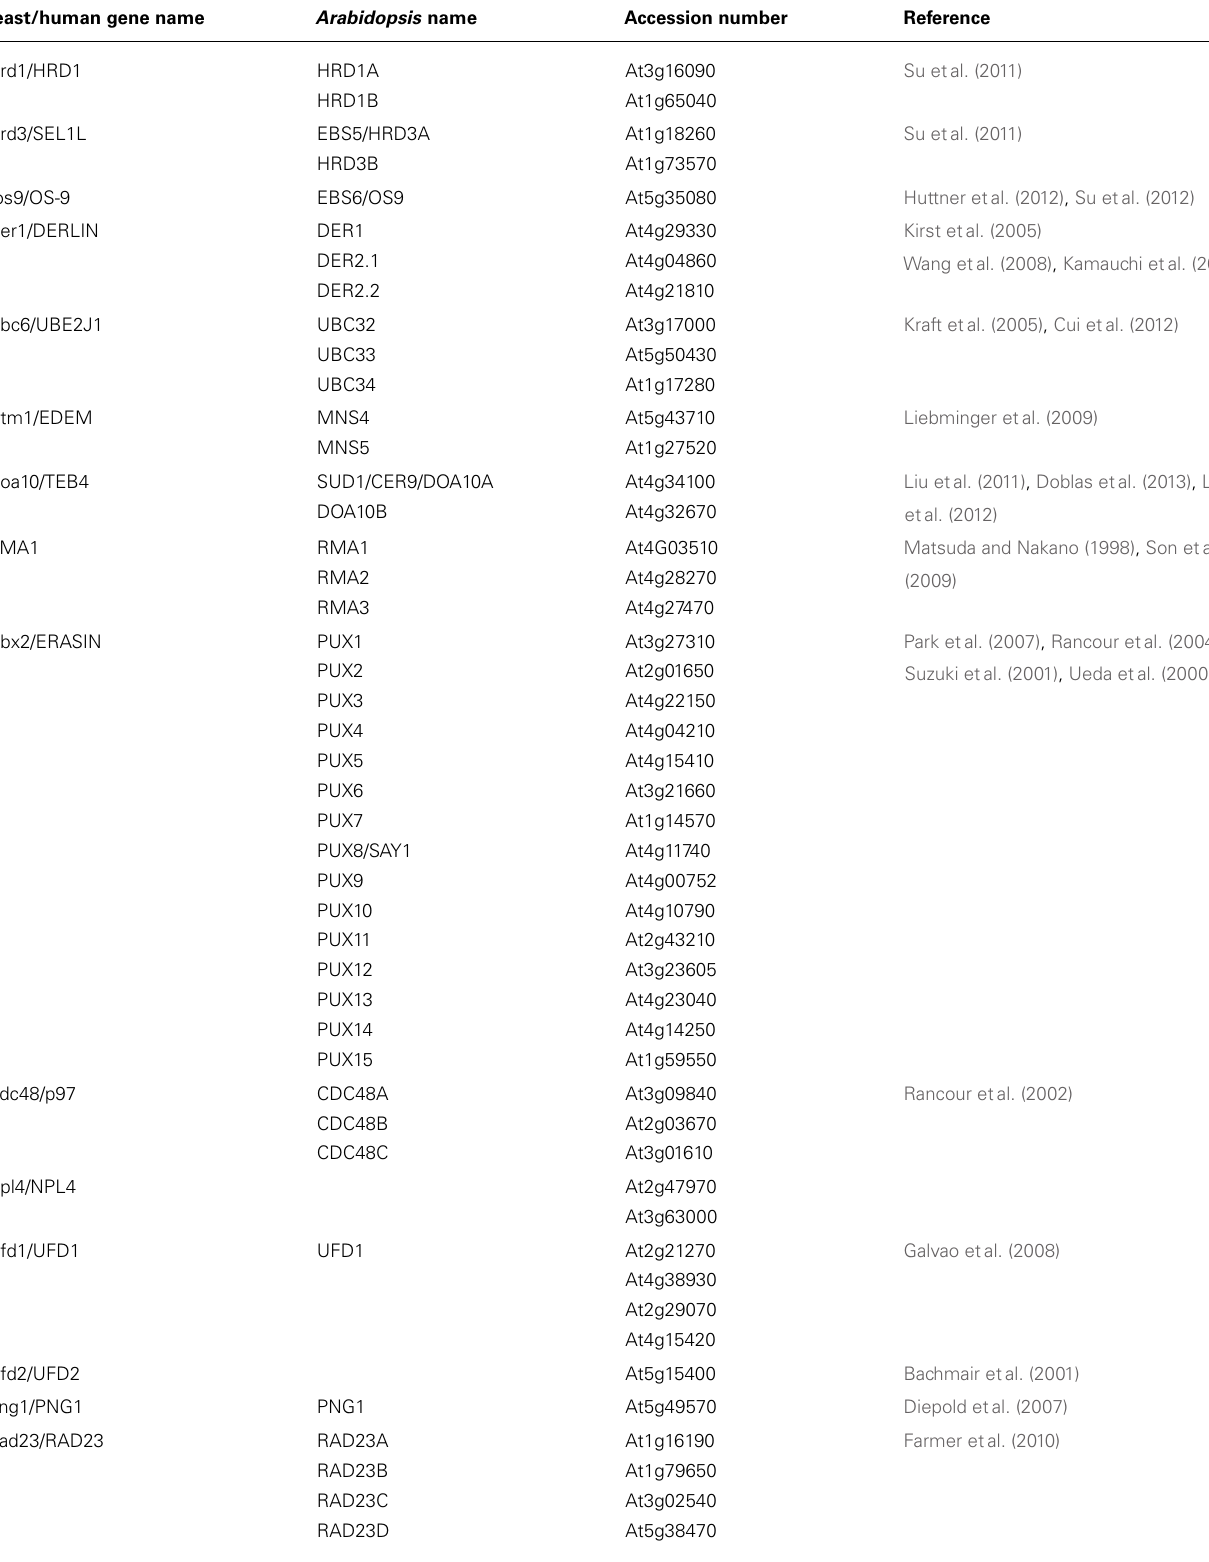
Table 1 |A list of known/predicted components of the Arabidopsis ERAD